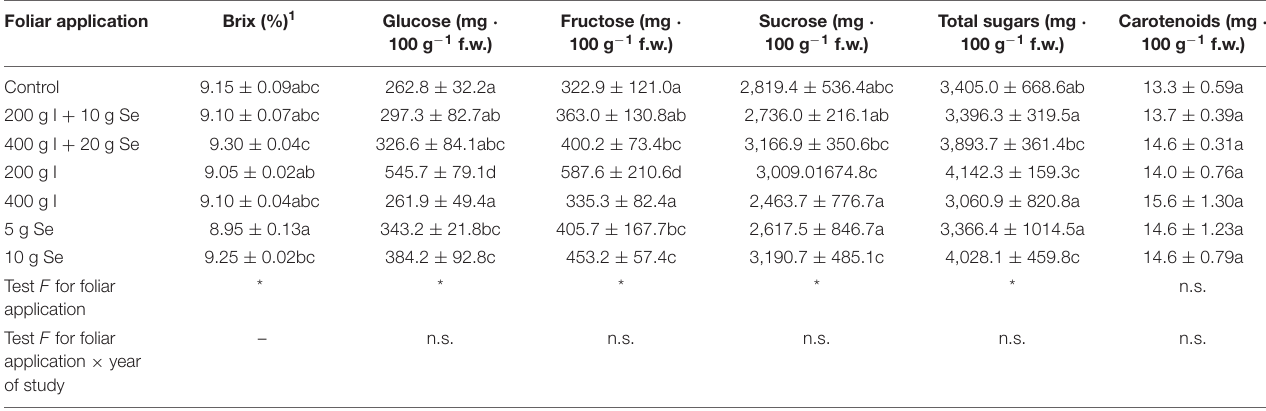
TABLE 8 | Content of and total soluble solids (Brix %); glucose, fructose, sucrose, and total sugars (the sum of the three sugars); and carotenoids in storage roots, depending on the foliar application of iodine and selenium. Foliar application